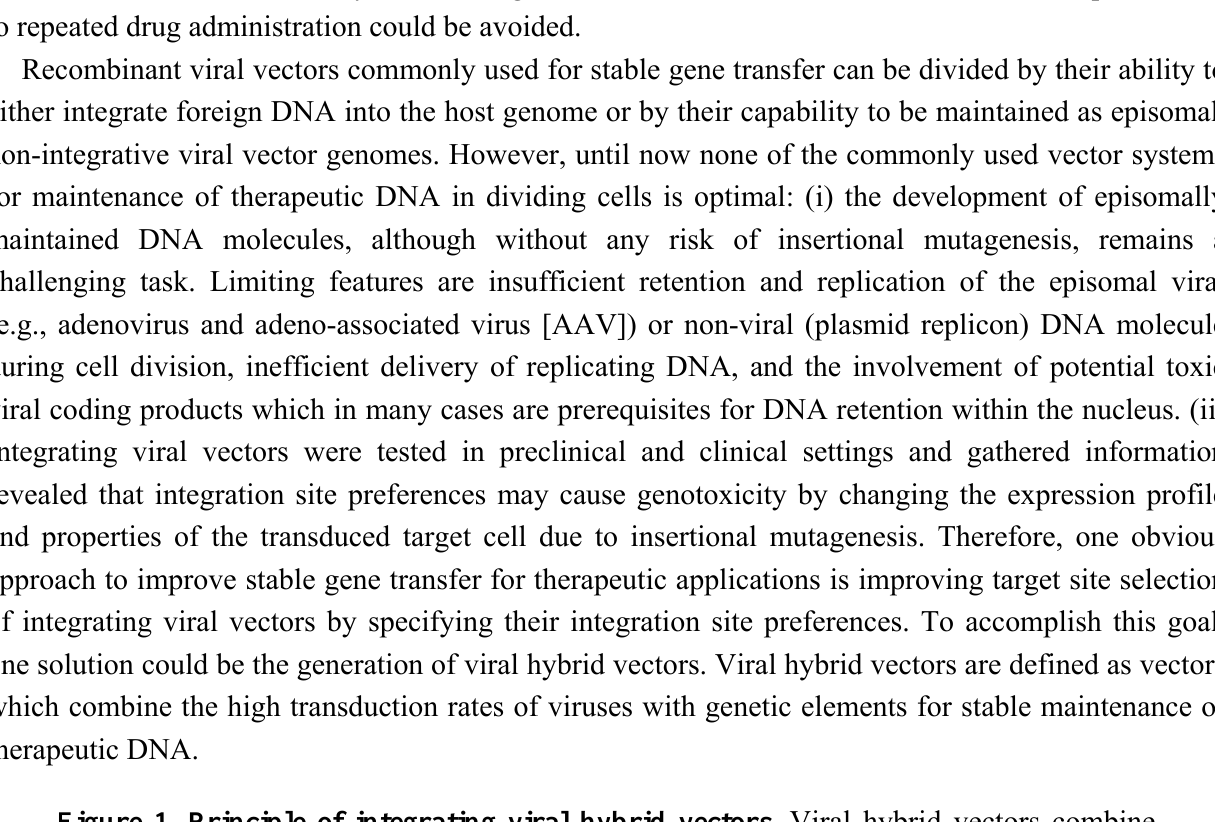
Figure 1. Principle of integrating viral hybrid vectors. Viral hybrid vectors combine efficient transduction rates of viruses (delivering vector) with improved genetic elements for stable maintenance of therapeutic DNA by somatic integration into the host genome of the target